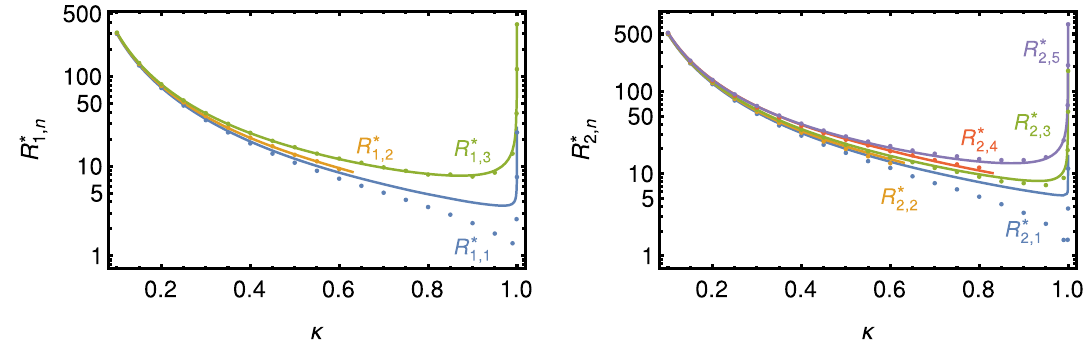
Fig. 4 Left: The three radii R ∗ vs. κ for the first excited state, N = 1. Dots are numerical results and the solid lines the prediction from Eq. (57). 1 , n Right: radii for the N = 2 excited state together with the prediction from Eq. (57)